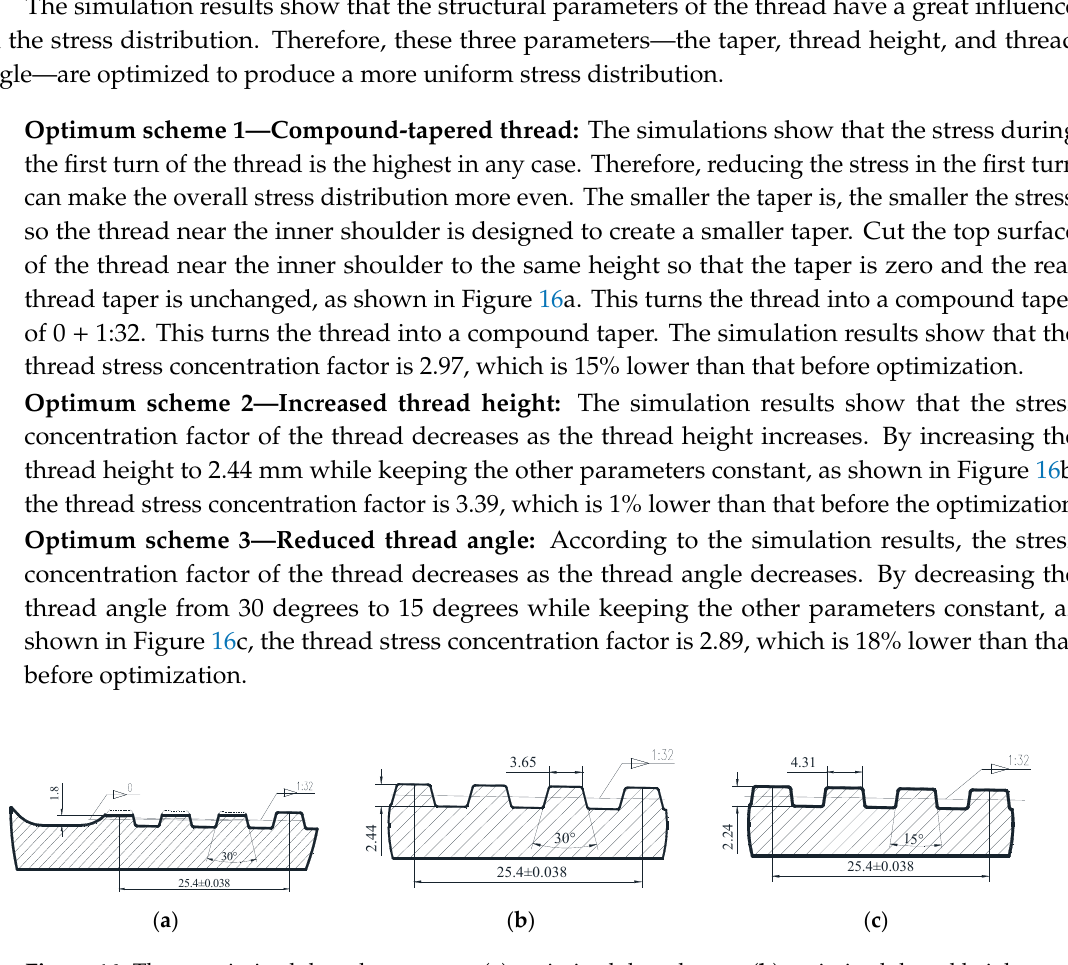
Figure 16. Three optimized thread structures: ( a ) optimized thread taper, ( b ) optimized thread height and ( c ) optimized thread angle.